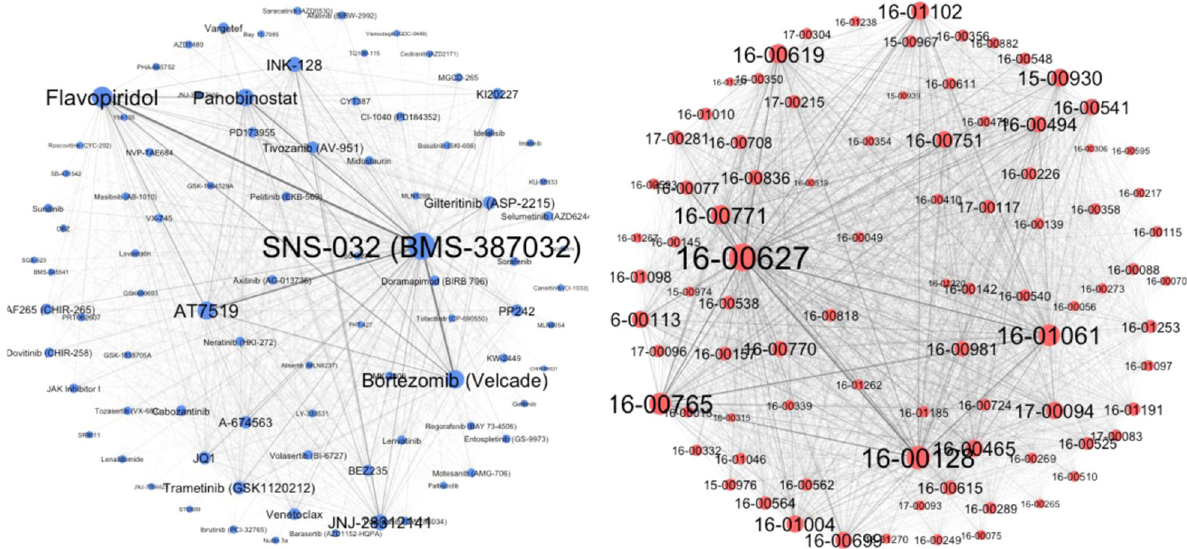
Fig. 4 DSN and PSN of the Beat AML dataset. The force-directed layout was selected to depict both networks. The thickness of the edges corresponds to the edge weight of the original bipartite networks after network projection, considering the weight values. The edge thickness represents the weight value of similarity between each pair of patient samples or small molecules. The node size is proportional to the strength of each node, which is the sum of the edge weights of the adjacent edges for each node. Source data are provided as a Source Data fi